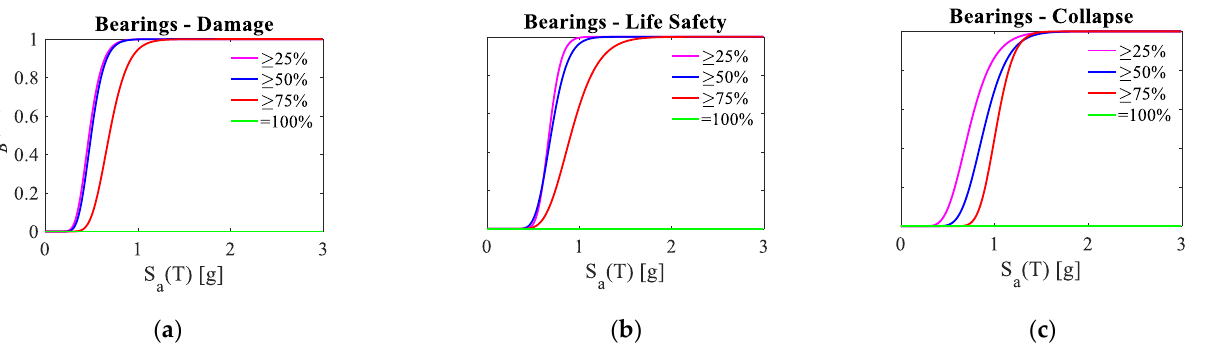
Figure 15. Type 3 quantitative fragility curves at ( a ) slight damage; ( b ) life safety; and ( c ) collapse performance levels for bearings: increasing percentages of involved elements (sets of devices).